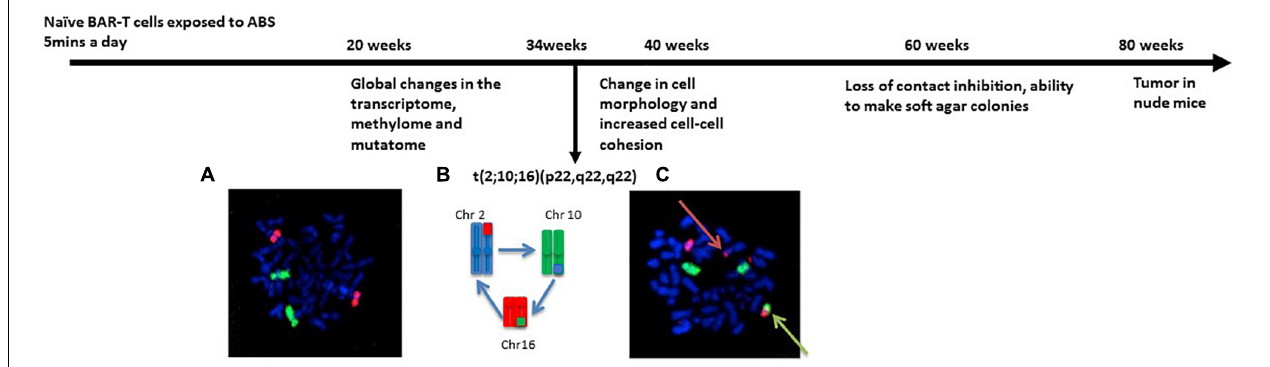
FIGURE 1 | Longitudinal events in Barrett’s epithelial carcinogenesis model. The naïve BAR-T cells exposed to acidified bile salt (ABS) 5 min everyday demonstrate increased columnar phenotype after 2 weeks that remains elevated at the subsequent time points. Although the BEC20W cells are similar to the parent BAR-T cells in their elongated shape and distribution on cell culture dishes, they demonstrate distinct changes in the transcriptome, methylome, and mutatome (Bajpai et al., 2012). With continued ABS exposure, distinct chromosomal changes were observed recurrently in the BEC34-week cells (Bajpai et al., 2013). After 40 weeks of ABS exposure, cells become oval in shape and form distinct clusters on culture dishes. Around 60 weeks, they make soft agar colonies and become malignantly transformed into tumors in nude mice at ∼ 80 weeks (Das et al., 2011). (A) Normal metaphase chromosomes of BEC20-week cells, painted with green (Chr10) and red (Chr16) whole chromosome fluorescent paints. The blue DAPI staining also reveals the normal Chr2 pairs. (B) Model of the translocations involving breakage and exchange of chromosome segments between Chr2 (blue), Chr10 (green), and Chr16 (red). (C) BEC40W cells with the hybrid red-green chromosome fusion t(10;16) (green arrow) and extra-red signal (red arrow) represent a segment of Chr16 translocated on Chr2 (blue). All metaphase chromosomes are stained blue with DAPI. TABLE 1 | Karyotypes of the six replicates of BEC20W cells exposed to ABS for 14 more weeks.